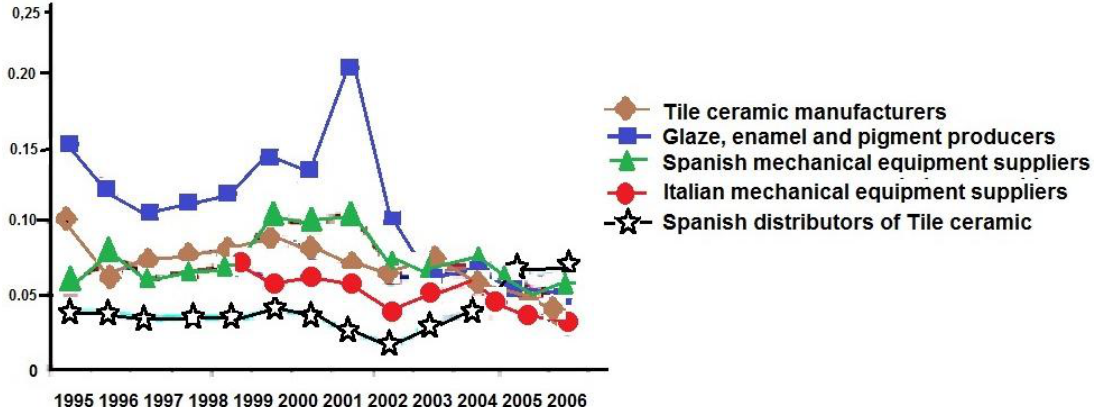
Figure 5. EBITDA on